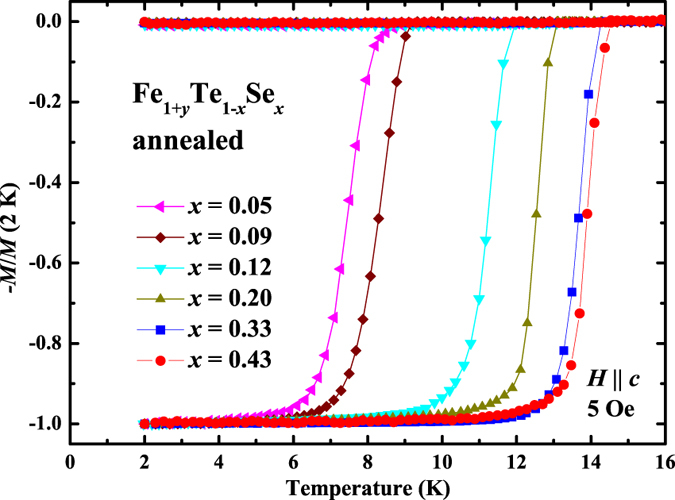
Temperature dependence of zero-field-cooled (ZFC) and field-cooled (FC) magnetization at 5 Oe for the O2-annealed Fe1+yTe1−xSex (0.05 ≤ x ≤ 0.43) single crystals.